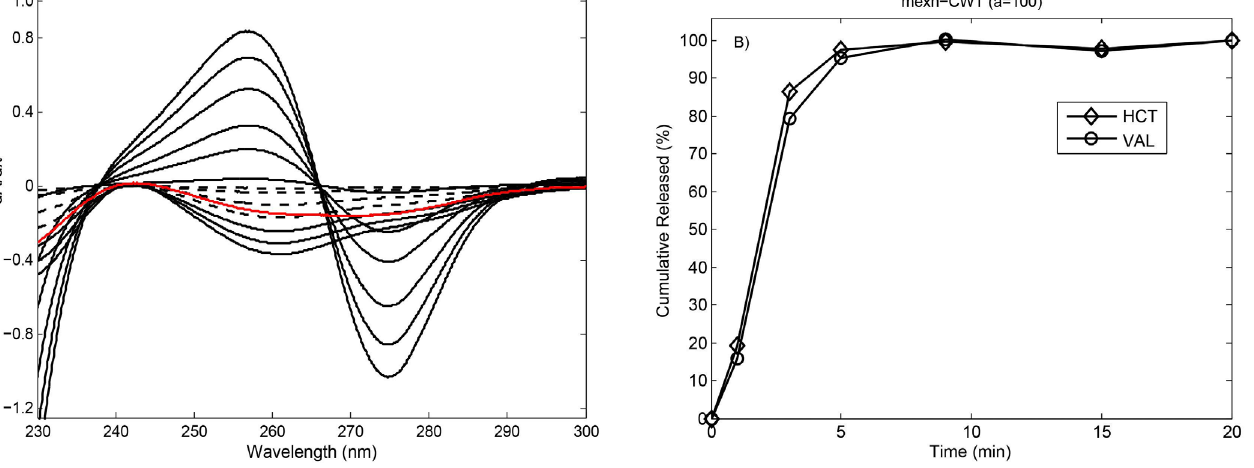
FIGURE 6A - Dissolution profiles of VAL and HCT obtained by applying db7-CWT method .